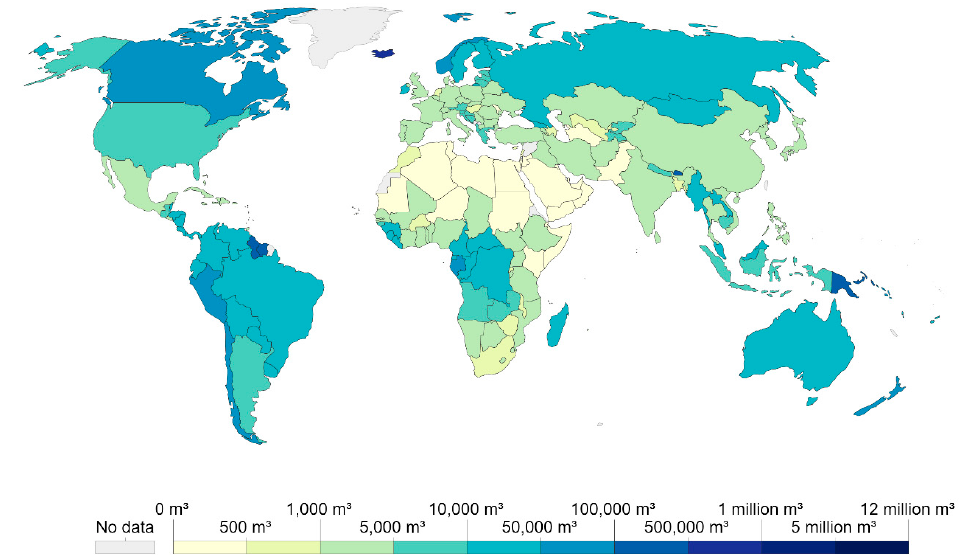
Figure 1. Available freshwater resources in the world (The World Bank, 2014).